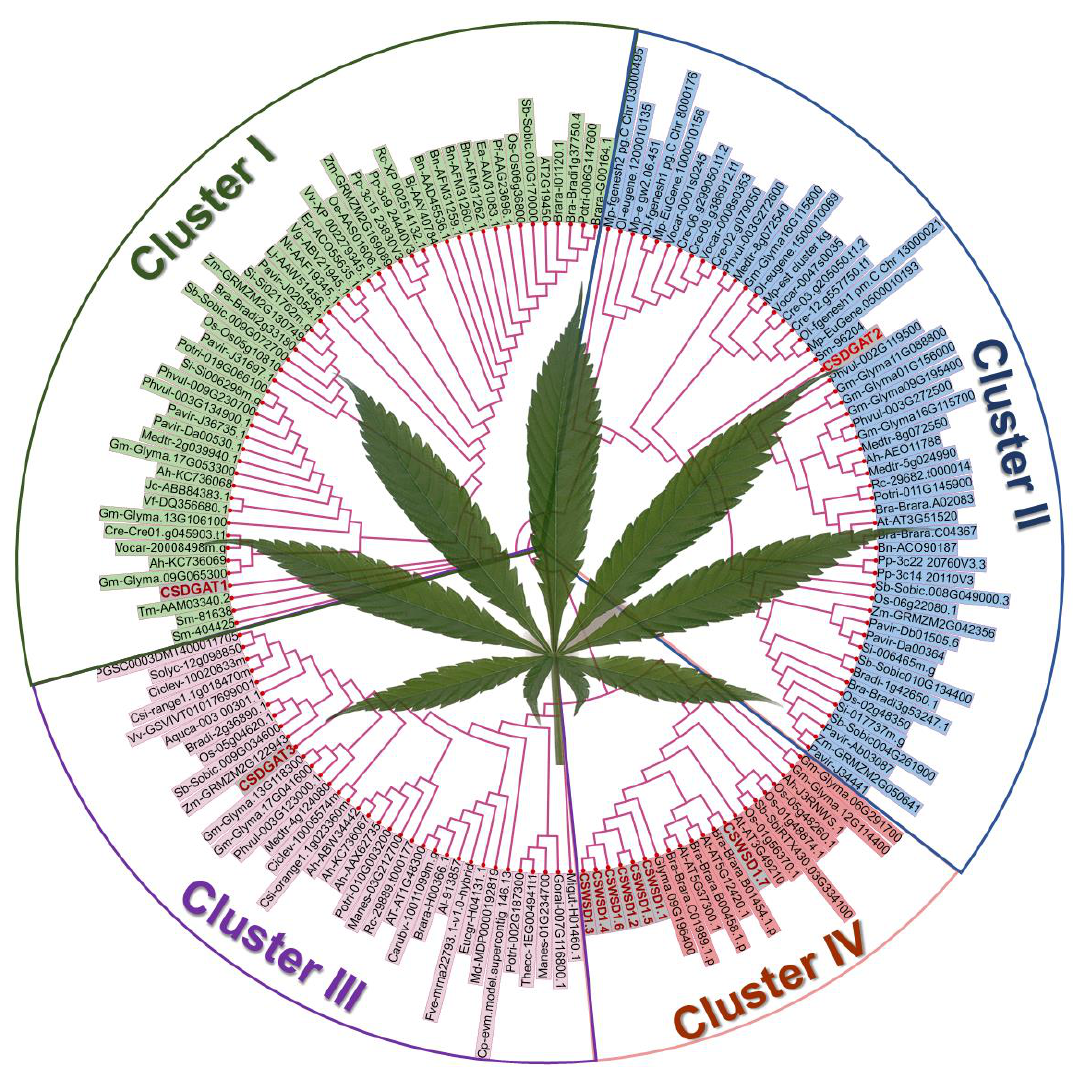
Figure 1. Phylogenetic analysis of CsDGAT gene family. A phylogenetic tree of CsDGAT proteins from C. sativa and other plants was constructed by MEGA 10.0 using full-length protein sequences. Different branches were distinguished with different color shades. CsDGAT proteins were repre- sented by red color. For the description of other species abbreviations involved in the figure, please see Additional Table S1.